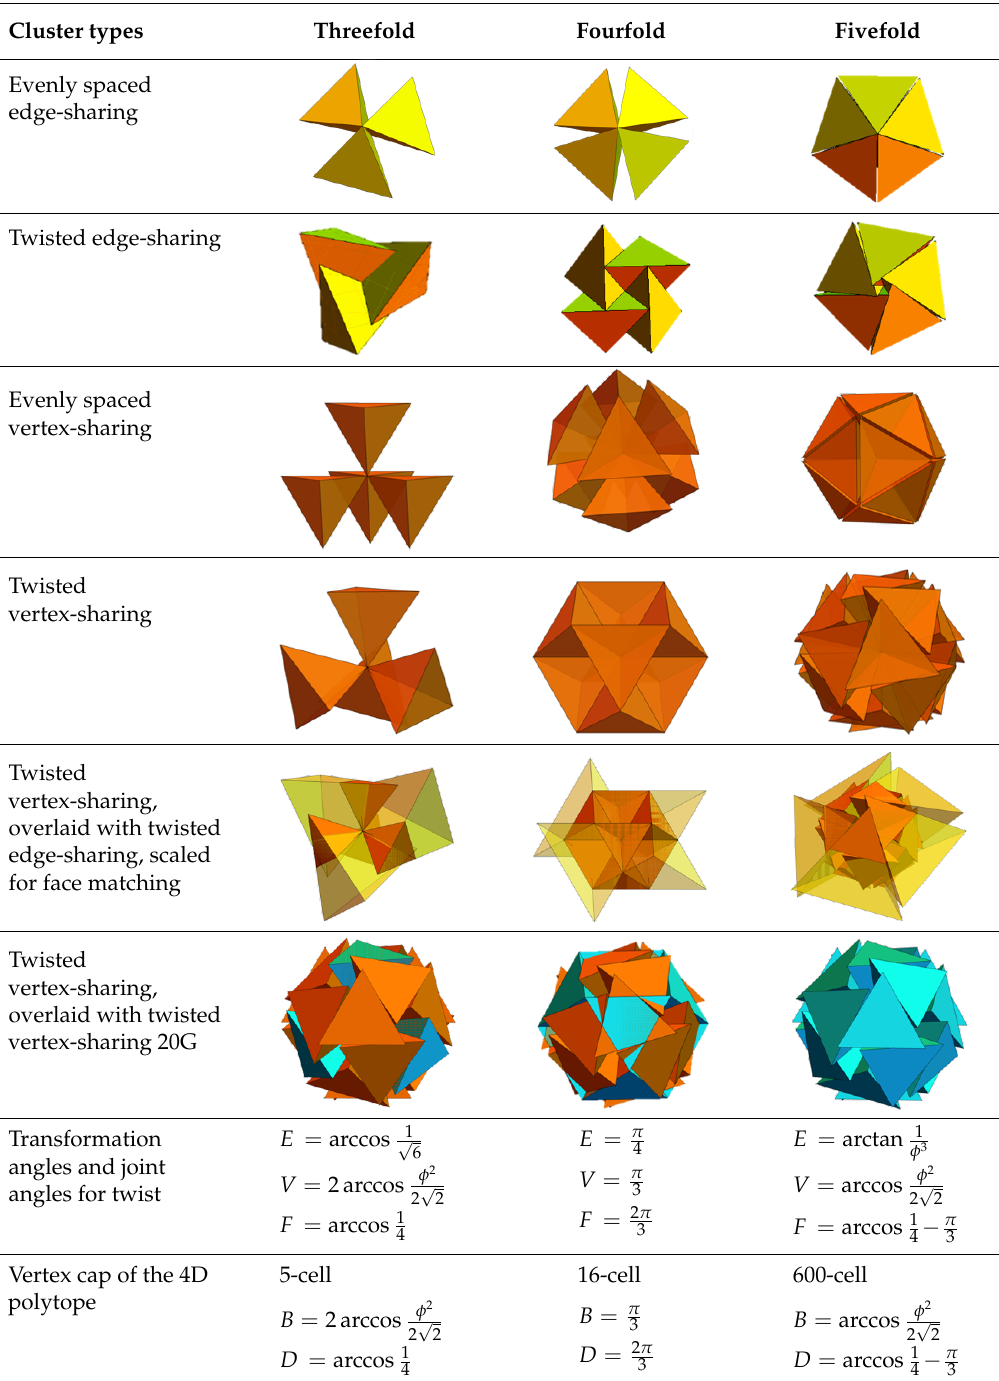
√ ( 1 + 5 ) . See the Supplementary 2